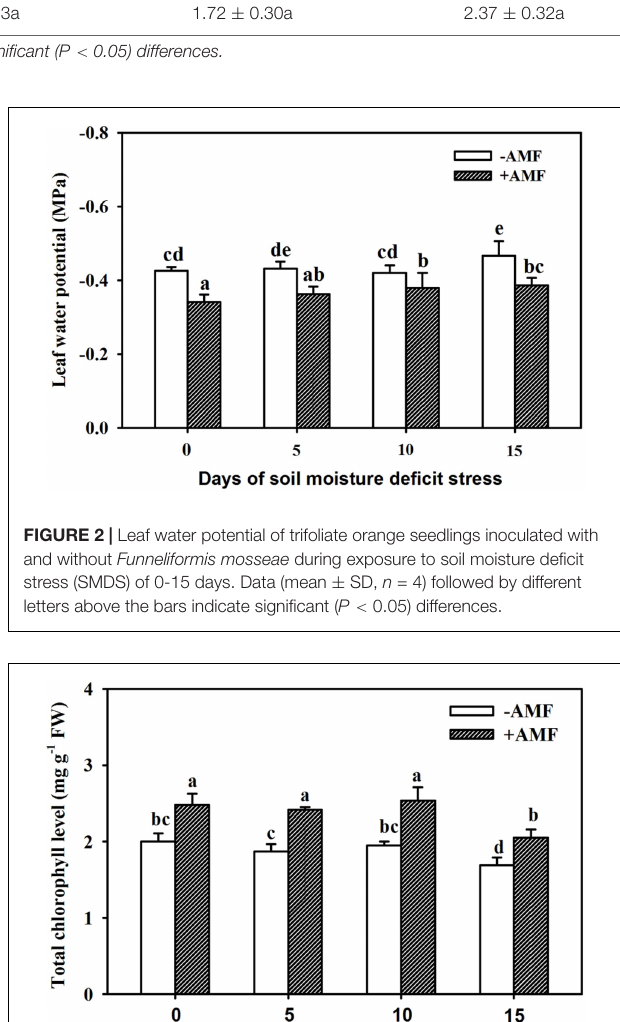
higher leaf (cid:57) than non-AMF-treated plants at 0, 5, 10, and 15 days of SMDS,